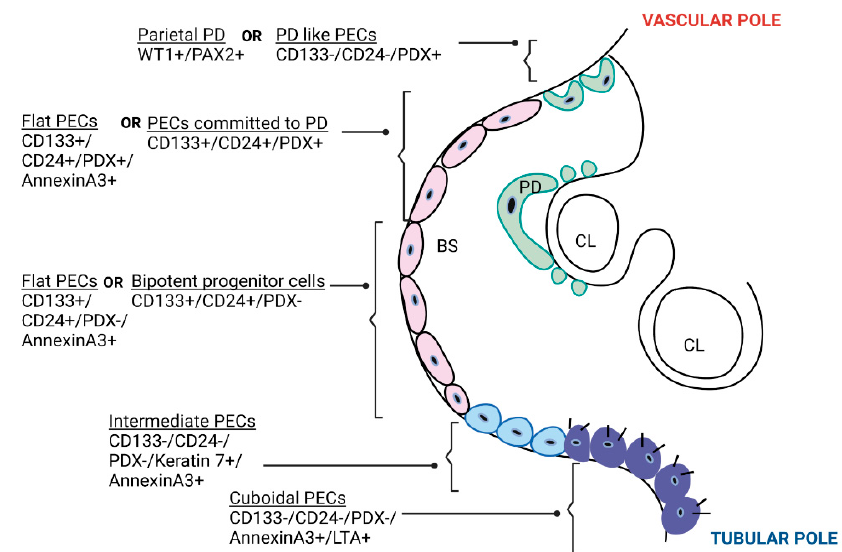
Figure 1. Types of parietal epithelial cells. A cartoon showing transverse section of a glomerulus showing types of PECs based on location, molecular phenotype [3,20] and morphology [21]. PECs based on stem cell marker (CD133/CD24) and PDX expression were located hierarchically along the Bowman’s capsule; differentiated cells resembling PD (CD133-CD24-PDX+) were located at the vascular pole, progenitor cells committed to PD (CD133+CD24+PDX+, also called “transitional cells”) were located between the vascular pole and tubular pole, and bipotent progenitor cells (CD133+CD24+PDX-, with a high regenerative capacity towards both PD and proximal tubular cells) were located at the tubular pole [3]. PECs based on morphology were: flat squamoid